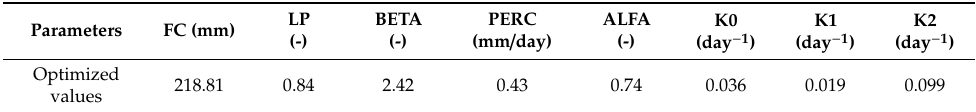
Table 2. Optimized parameters for Melka Kuntrie subbasin found in Hydrologiska Byråns Vattenbalansavdelning (HBV) model